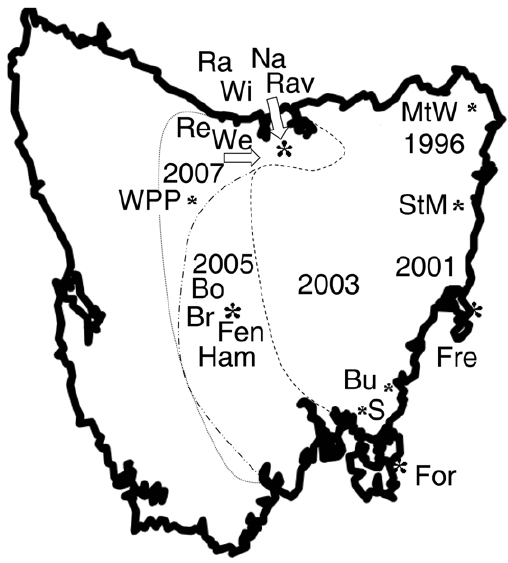
Figure 2. Tasmanian devil samples were collected from 17 locations across Tasmania. Tumour progression by 2003 depicted with dashed, by 2005 with dashed-dotted and by 2007 with dotted lines. Dates indicate the progression dates of DFTD. Location abbreviations: Bo=Bothwell, Br=Bronte Park, Bu=Buckland, Fen=- Fentonbury, For=Forestier, Fre=Freycinet, Ham=Hamilton, MtW=Mt William, Na=Narawntapu, Ra=Railton, Rav=Ravenswood, Re=Reedy Marsh, S = Sorell, StM= St. Marys, We = Weegena, Wi = Wisedale, WPP=West Pencil Pine. U= 28, P =0.0173 and U= 28.5, P= 0.013, respectively; TERT